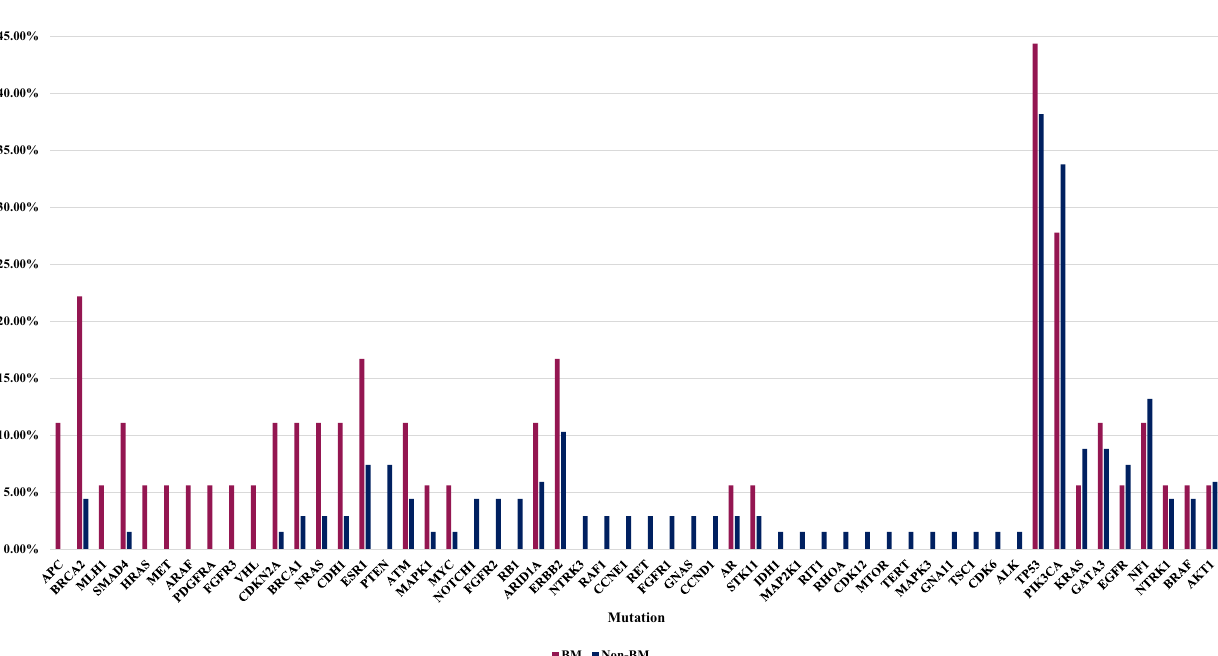
Fig. 2 Mutation spectrum (baseline cfDNA) in patients with MBC who developed brain metastases during disease course (BM) vs those without brain metastases (non-BM). The mutation spectrum varied between the 2 cohorts as shown.